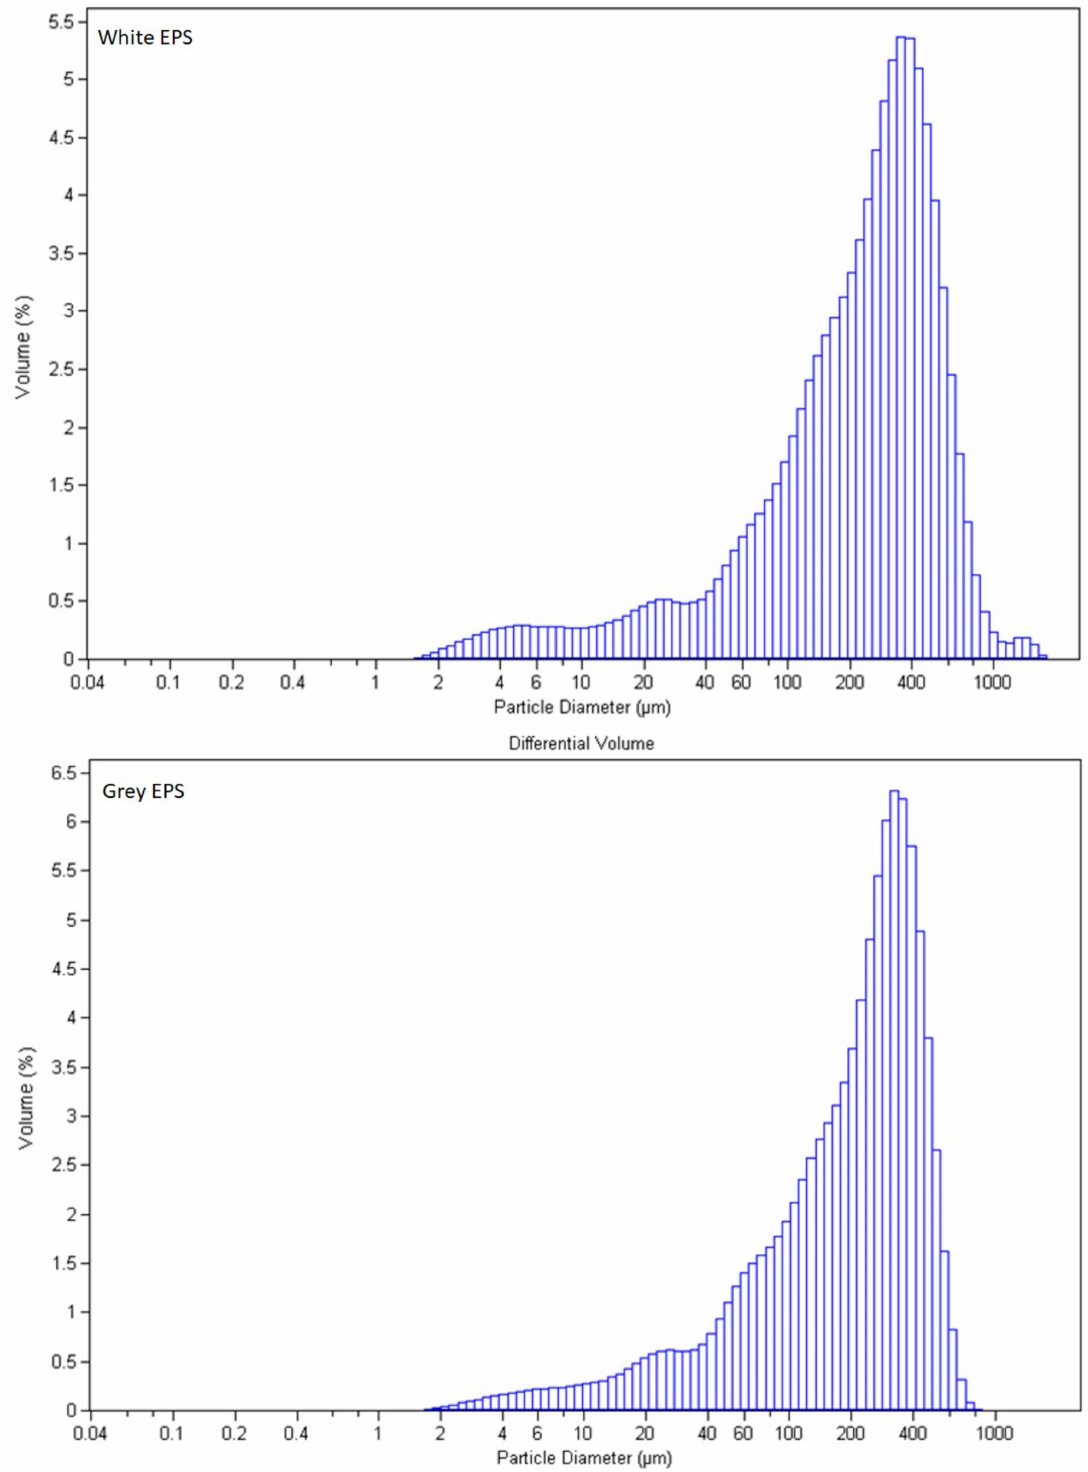
Figure 8. Particle size distribution of white and grey EPS